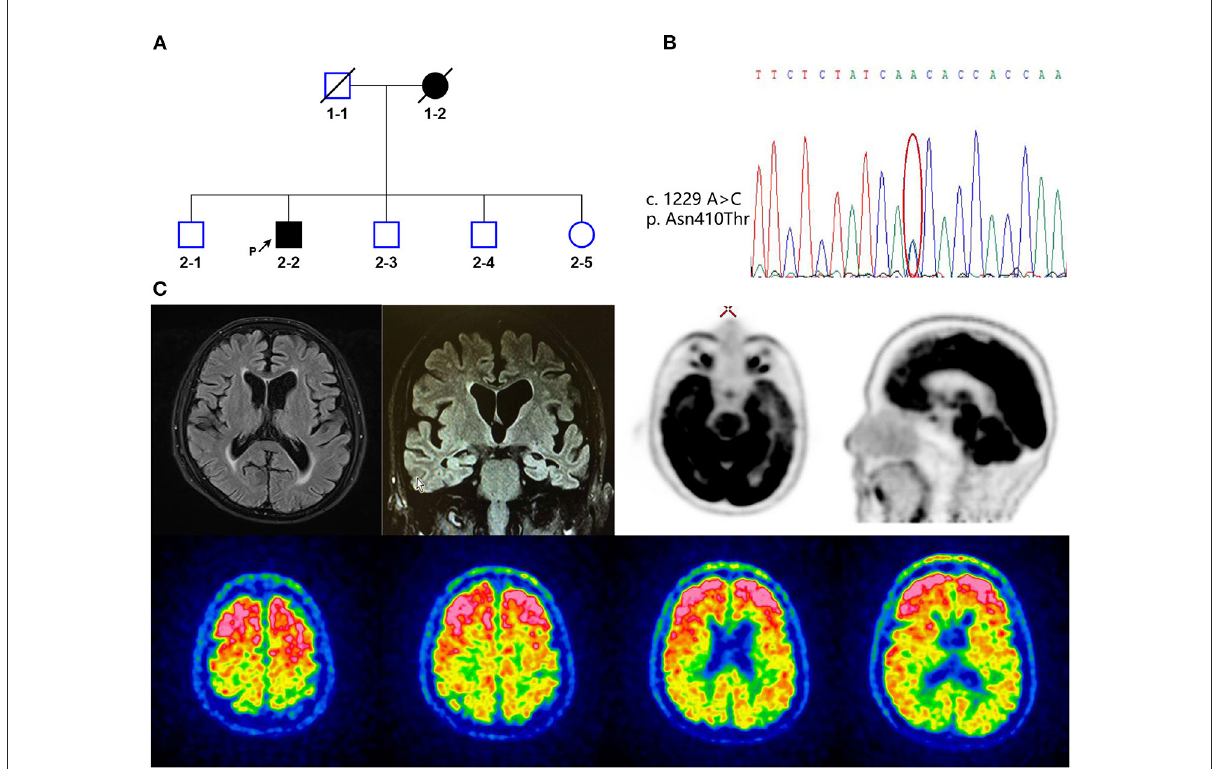
FIGURE1 (A) Family pedigree of the patient with alpha-2-macroglobulin (A2M) p.Asn410Thr (2-2). Black arrow indicates the proband. Square indicates male, circle indicates female, and slashes denote deceased members. Open squares and circles mean asymptomatic family members, who were not diagnosed with disease. Filled squares and circles indicate patient. (B) Whole-exome sequencing data of A2M p.Asn410Thr (c.1229A > C) mutation. (C) Representative MRI FLAIR weighted (up-left), FDG-PET (up-right), and PIB-PET images (bottom) of the